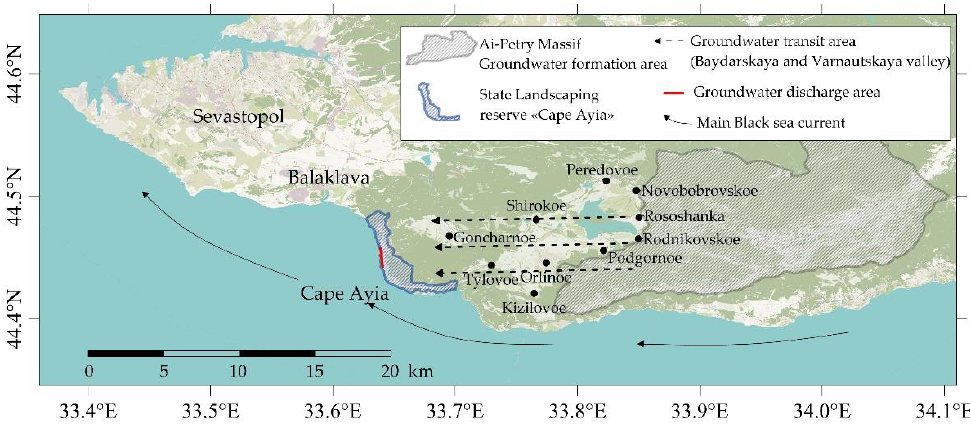
Figure 5. Areas of formation, transit, and discharge of groundwater in southwestern Crimea.